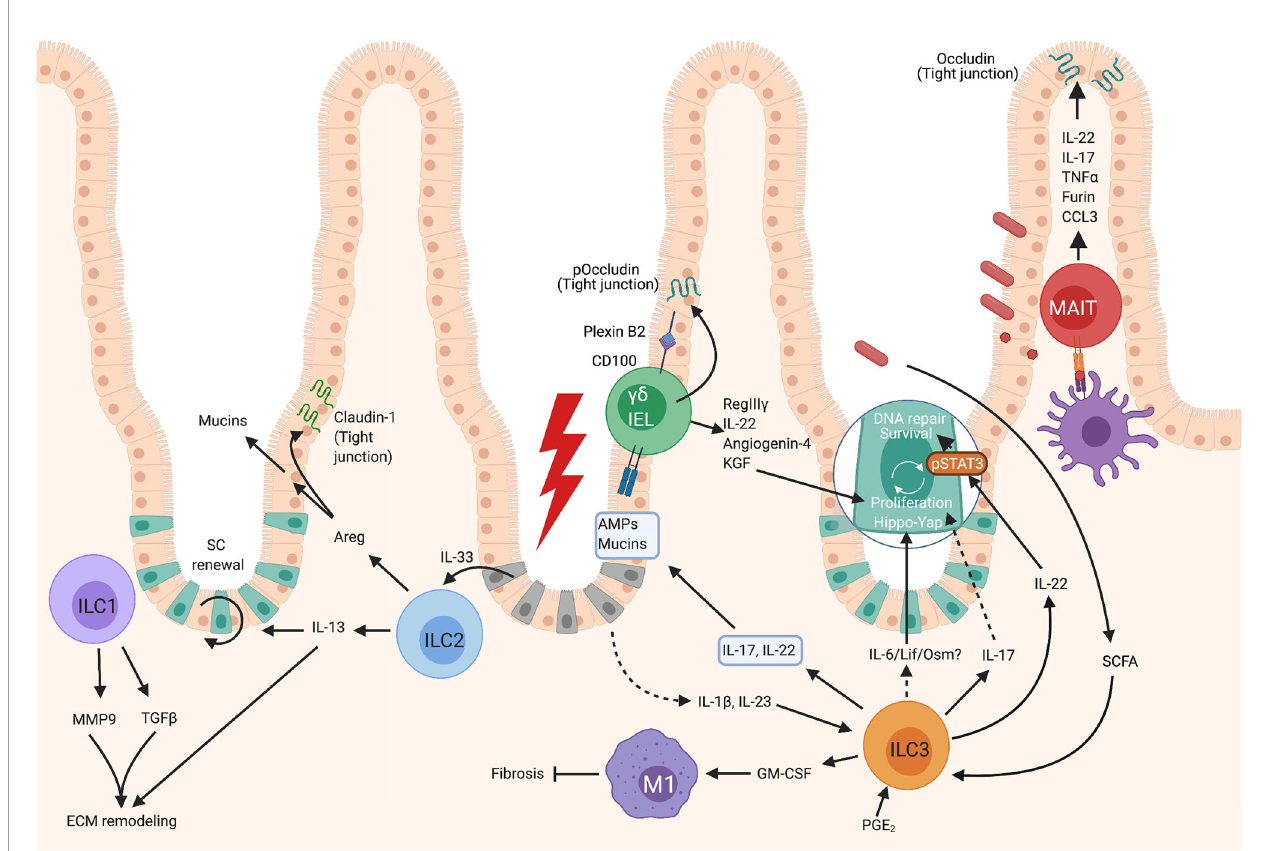
FIGURE 1 | Roles of unconventional lymphocytes in intestinal repair. Gut ILC1 can produce MMP9 and TGF b 1 which contribute to extracellular matrix remodeling- a crucial part of repair. ILC2s become activated after exposure to IL-33 released by damaged epithelium, which results in their production of IL-13, which contributes to extracellular matrix remodeling and epithelial cell proliferation. Activated intestinal ILC2 also produce Areg which both enhances mucin production by epithelial cells increasing the mucus layer, and upregulates Claudin-1, increasing tight junction strength and reinforcing the barrier. Gut gd T cells, or gd IELs, can contribute to repair by the production of KGF which promotes epithelial proliferation, and via the production of AMPs such as RegIII g . In gut, the contribution of MAIT cells to healing responses remains relatively unknown, however these cells have been observed to respond similarly to human peripheral blood MAIT and can strengthen epithelial barrier integrity by inducing the tight junction protein, occludin, and by enhancing mucin expression to bolster the mucus layer. Intestinal ILC3s can become activated by PGE 2 , SCFAs, or IL-23 and IL-1 b . Activated ILC3s produce IL-22 which promotes epithelial stem cell maintenance in a STAT3 dependent manner, and can also promote the DNA damage response. ILC3s can also promote epithelial cell proliferation via a Hippo/Yap-1 pathway downstream of gp130. The factors released by ILC3s which signal via gp130 are not known, but may be IL-6, Lif or Oncostatin M as these all signal via gp130-coupled receptors. Activated ILC3s also produce GM-CSF which contributes to M1 polarization of macrophages which inhibit healing, but also inhibit fi brosis which is associated with scar formation. ILC3s